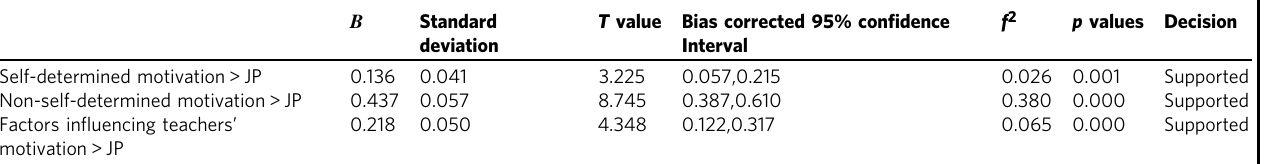
Table 5 Hypothesis